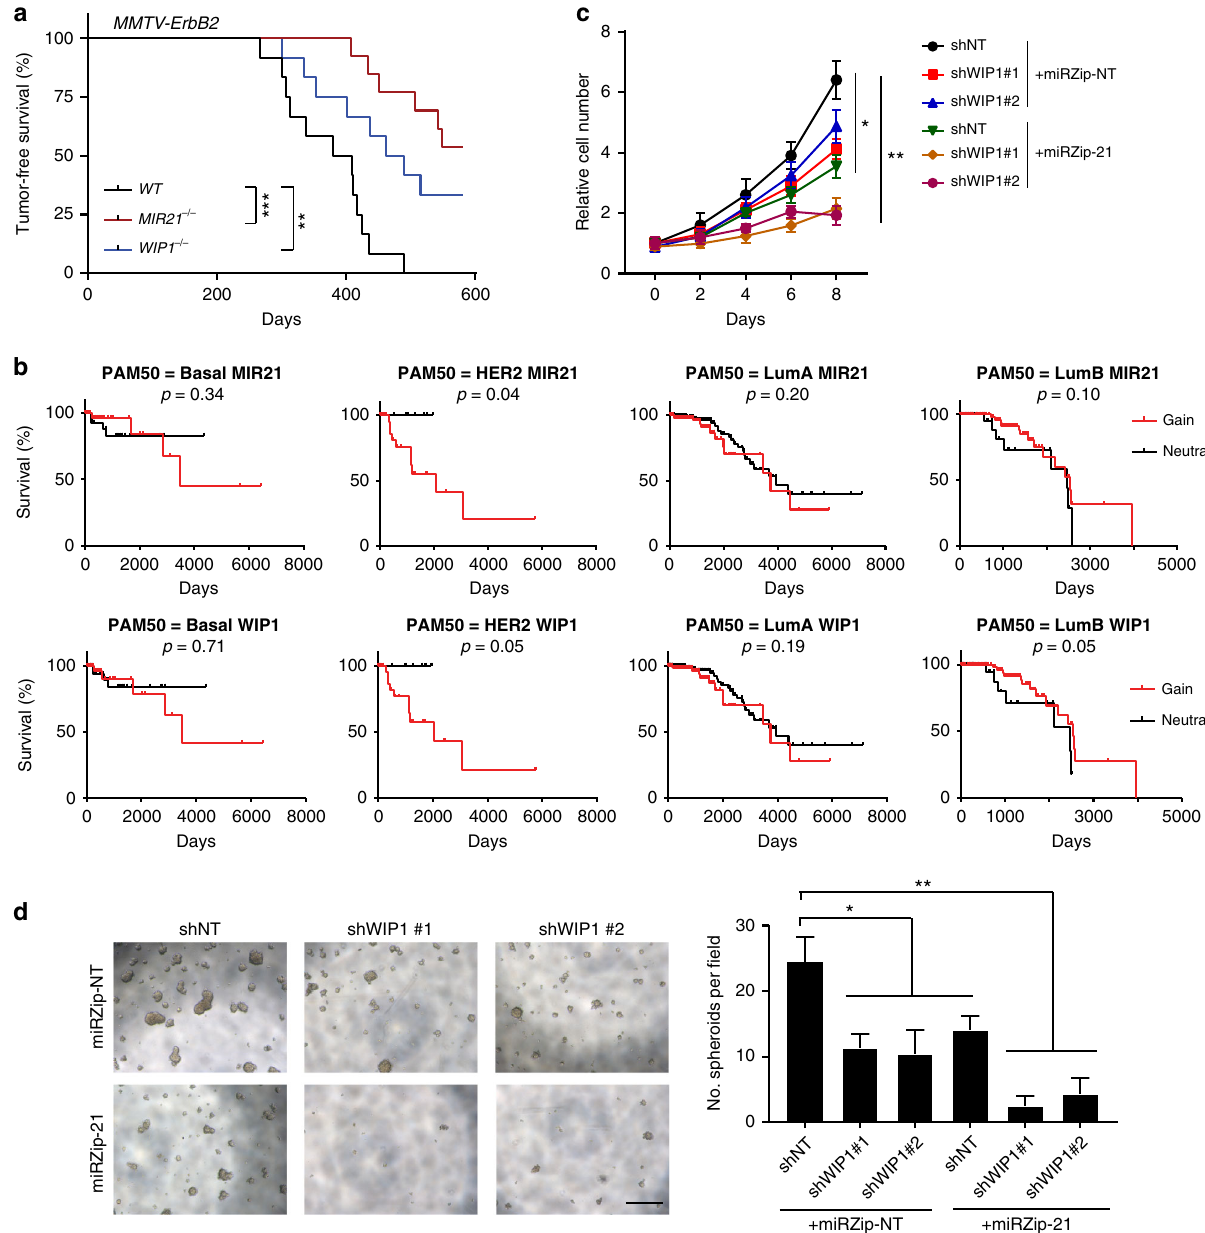
Fig. 2 Suppression of miR-21 and WIP1 inhibits proliferation and tumorigenic potential of HER2 + breast cancer cells. a Kaplan – Meier analysis of tumor-free survival in female MMTV-ErbB2 wild type (n = 12), MMTV-ErbB2; WIP1 − / − ( n = 12) and MMTV -ErbB2; MIR21 − / − ( n = 13) mice. b Ampli fi cation of MIR21 and WIP1 is associated with poor overall survival in patients with HER2 + breast cancer, but not with patients with luminal A, luminal B or basal-like breast cancer. c Cell growth curve of H605 cells ( MMTV-ErbB2 tumor cells) expressing doxycline (Dox)-inducible control shRNA or speci fi c shRNA targeting WIP1 or mature miR-21. d Mammosphere formation assay in H605 cells expressing Dox-inducible control shRNA, speci fi c shRNA targeting WIP1 or mature miR-21. Right panel demonstrates the quantitative data using Image J software. Scale bar, 500 µ m. * p < 0.05; *** p < 0.001**; *** p < 0.001; Log-rank Mantel – Cox test ( a , b ) and one-way ANOVA followed by Tukey ’ s t test ( c , d ) were used. Data are presented as mean ± SD and are representative